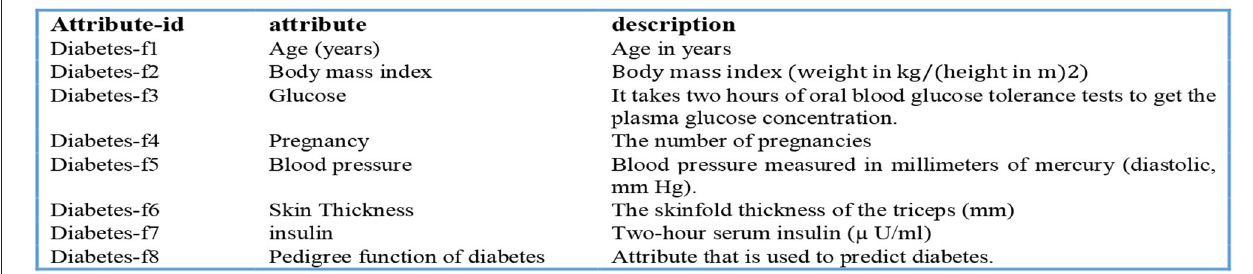
FIGURE 2 | Parameters used to predict the likelihood of